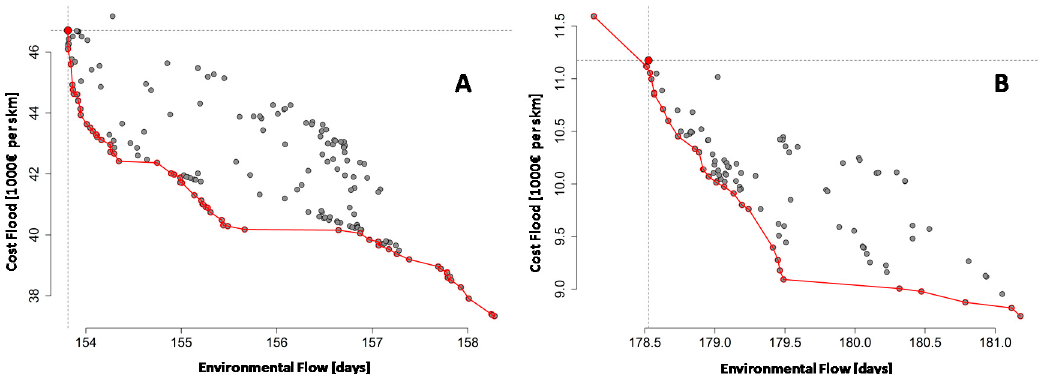
Figure 8. Strategies obtained optimizing the environmental flow and cost flood criteria for the flood-related family of measures in region 11 ( A ) and 13 ( B ). Strategies along the red line are those that define the trade-off or Pareto frontier. More details about these Pareto strategies are shown in Table 5 ( A ) and Table 6 ( B ).